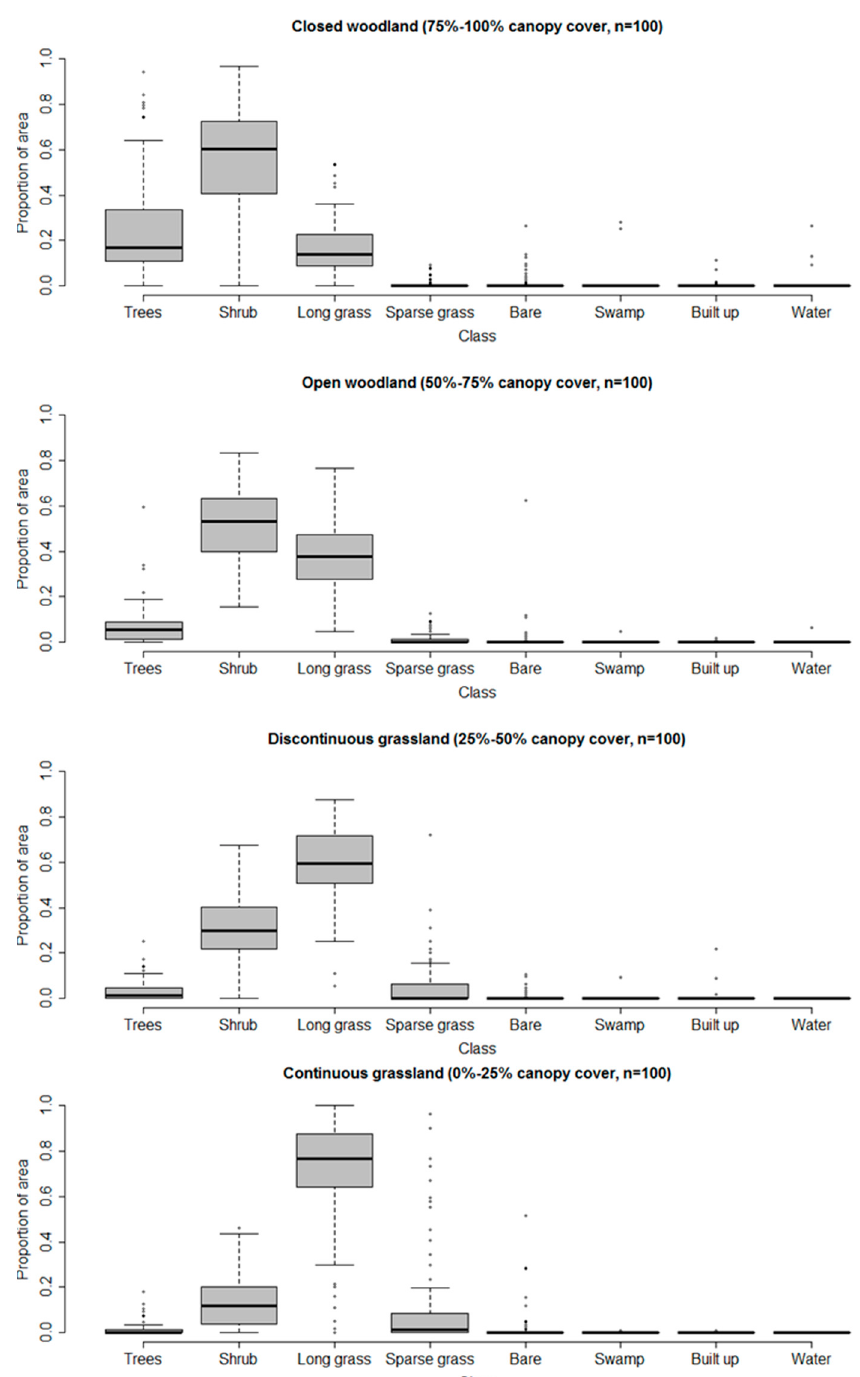
Figure 8. Correspondence between VHR land cover classes and the four Landsat woodland and grassland classes for the 2014 imagery.